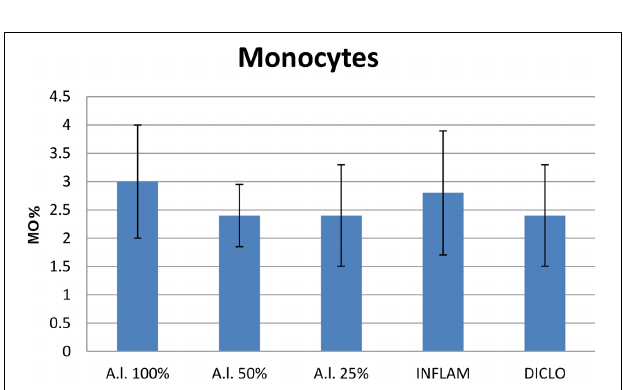
FIGURE 6 | Phagocytic index (PI) of A. laxmannii extract. A.l. 100% – the animals received 5 mL/kg BW A. laxmannii ethanol extract 100% (100 mg dw/mL), A.l. 50% – the animals received 5 mL/kg BW A. laxmannii ethanol extract 50% (50 mg dw/mL), A.l. 25% – the animals received 5 mL/kg BW A. laxmannii ethanol extract 25% (25 mg dw/mL), Inflam – Inflammation was induced by i.m. injection of turpentine oil (6 mL/kg BW), Diclo – the animals received 20 mg/kg BW diclofenac ( p <